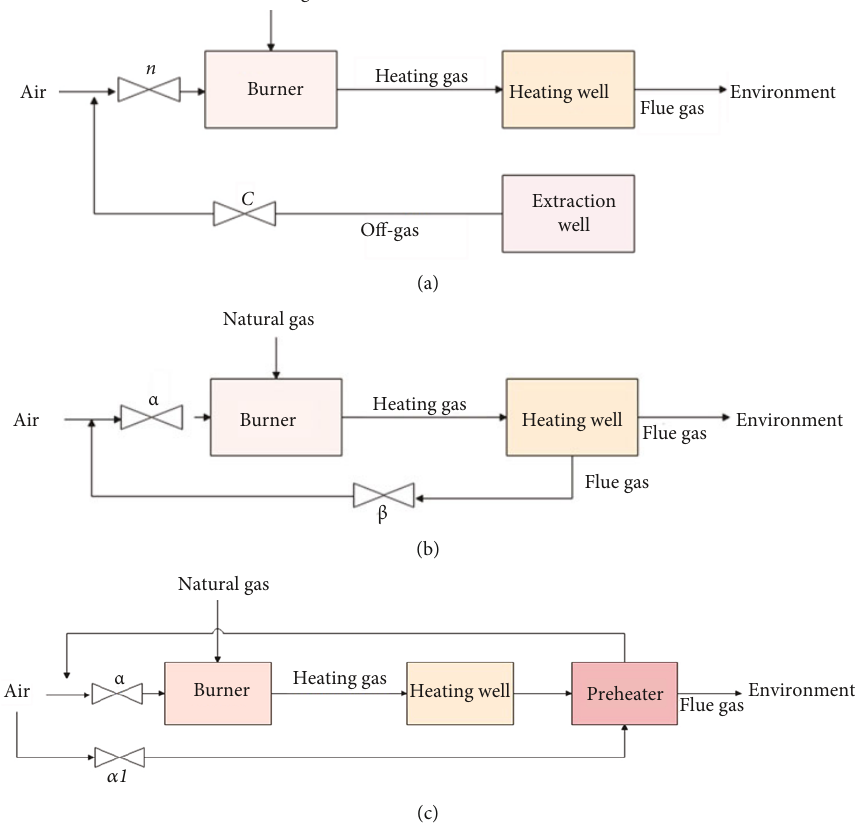
Figure 3: Flow diagrams of gas in ISGTR system in three energy-saving strategies: (a) o ff -gas burn-back mode; (b) heat-returning mode; (c) air-preheating